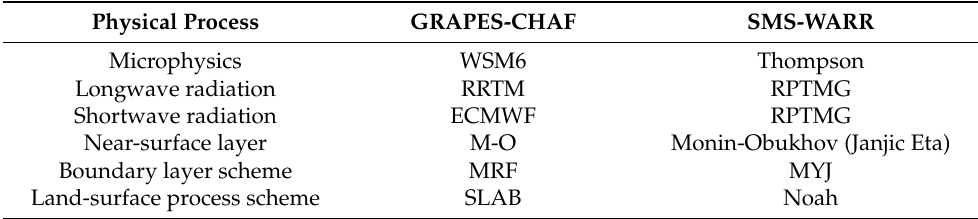
Table 1. The parameterization schemes in GRAPES-CHAF and SMS-WARR models. Physical Process GRAPES-CHAF SMS-WARR Microphysics WSM6 Longwave